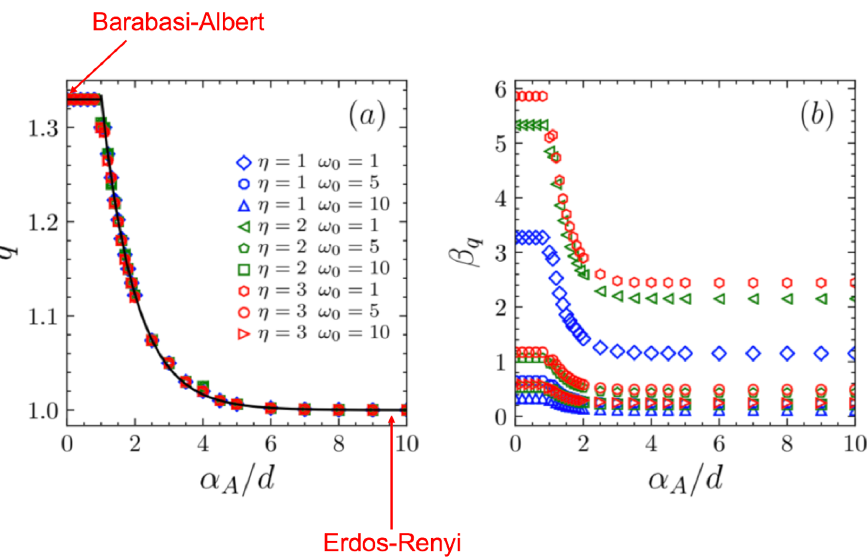
− β q ε q . ( a ) q as a